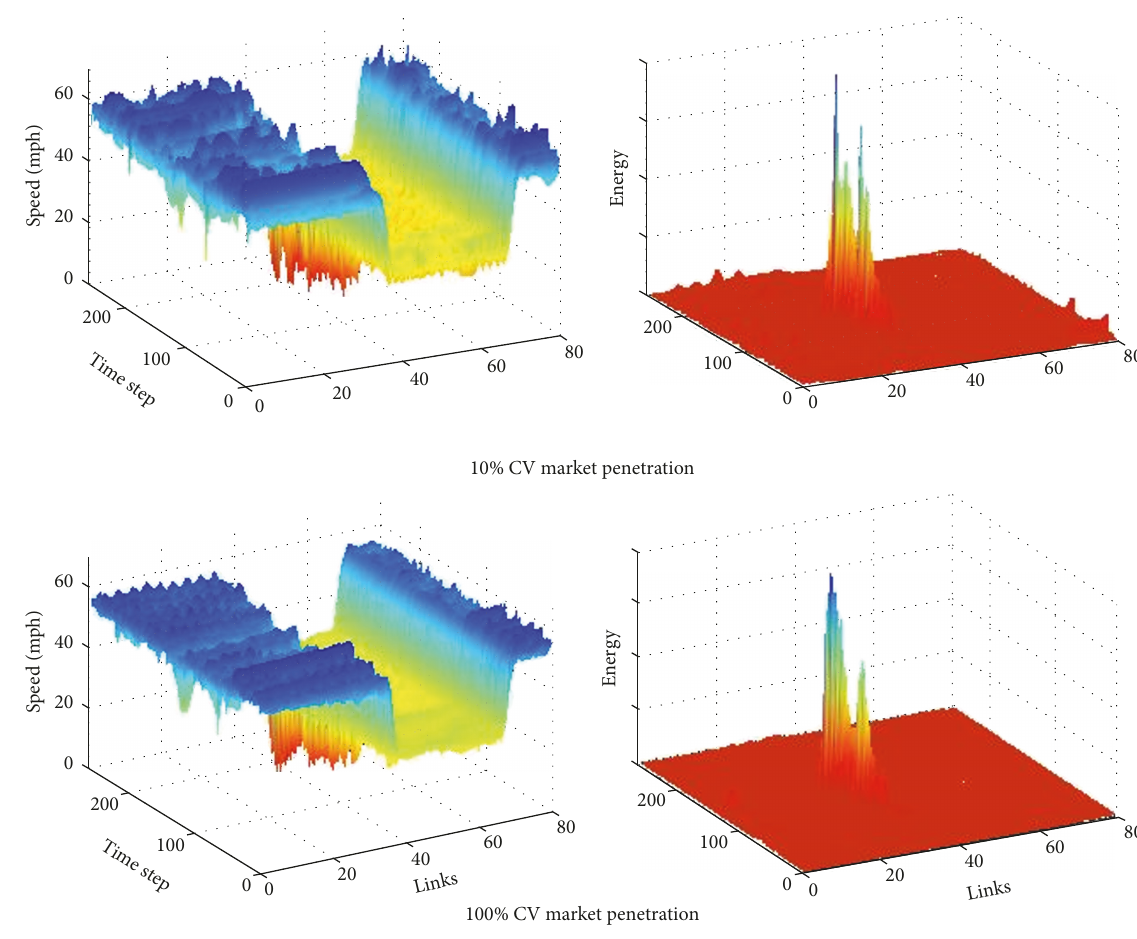
Figure 7: Speed and energy comparison under different market penetration